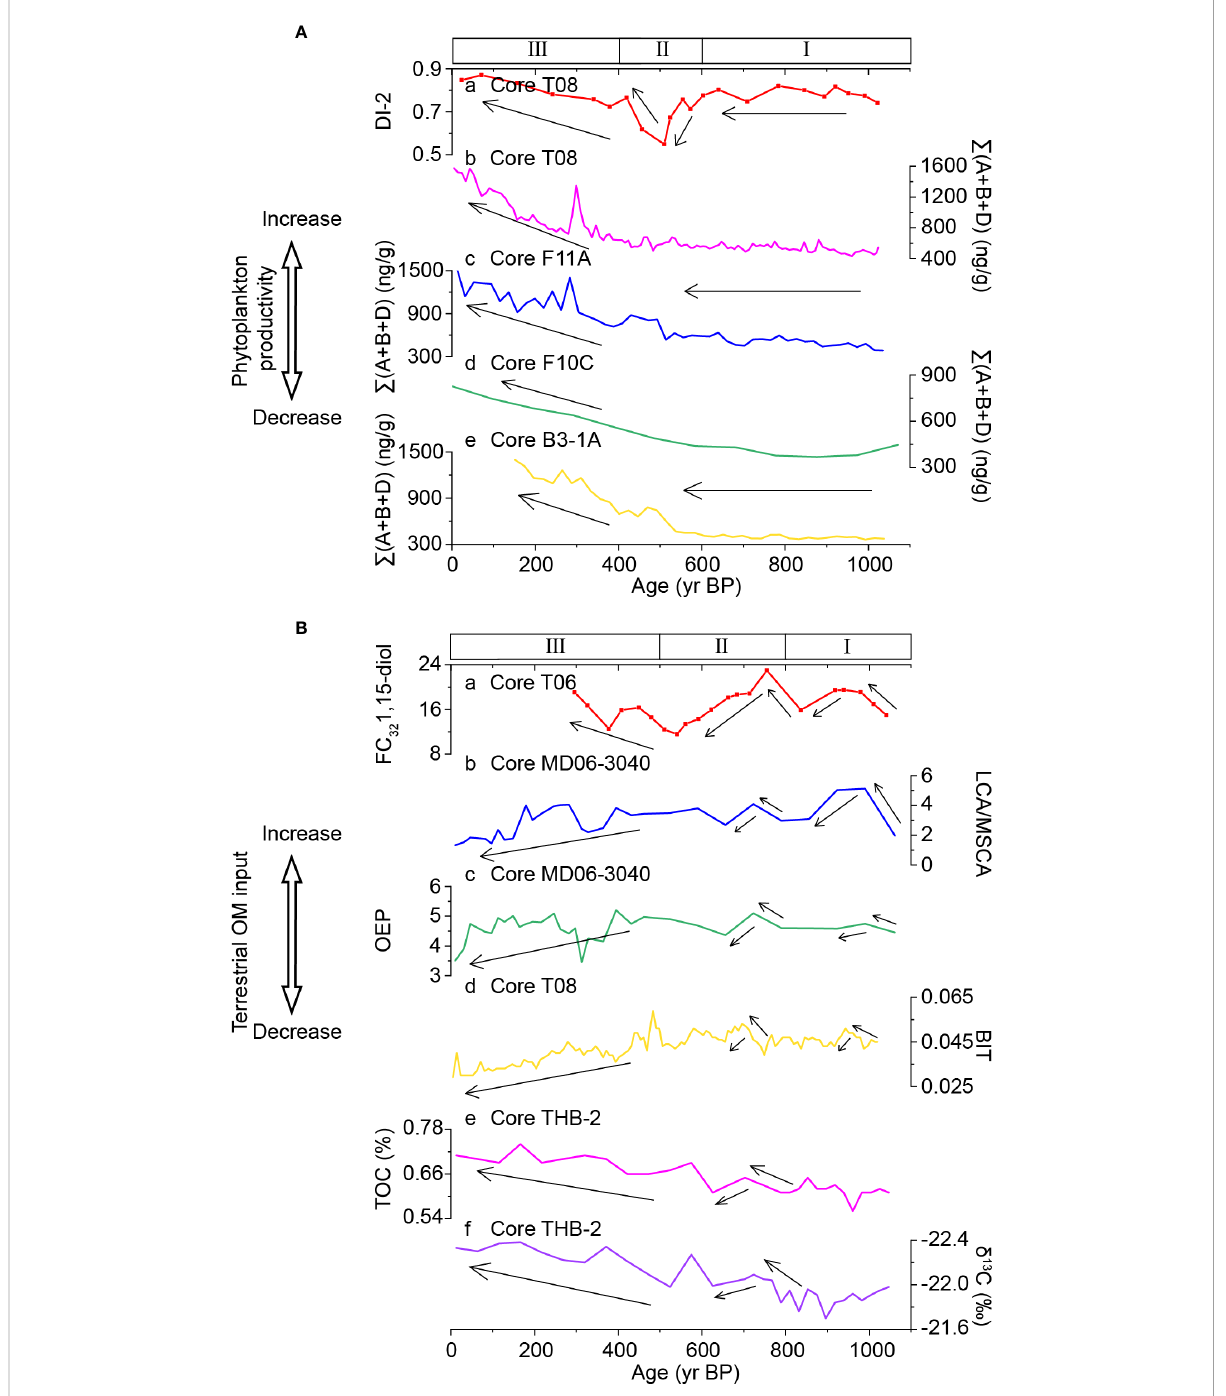
FIGURE 5 Organic geochemical indicators synthesis for reconstructing changes in upwelling intensity and tracing terrestrial OM input in the ECS. (A) Phytoplankton productivity records: (a) DI-2 record from core T08; ∑ (A + B + D) records, (A,B,D refer to alkenones, brassicasterol, and dinosterol, respectively) used here to represent changes in phytoplankton productivity, from (b) core T08 (Wu et al., 2018), (c) core F11A (Wang et al., 2019), (d) core F10C (Wang et al., 2019), and (e) core B3-1A (Wang et al., 2019); (B) Terrestrial OM input records: (a) FC 32 1,15-diol proxy in core T06; (b) LCA/MSCA ratio in core MD06-3040 (Zheng et al., 2018); (c) OEP proxy in core MD06-3040 (Zheng et al., 2018); (d) BIT index in core T08 (Zhou et al., 2020); (e) TOC values in core THB-2 (Hu et al., 2014); (f) d 13 C values in core THB-2 (Hu et al.,